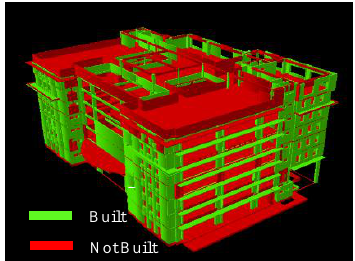
Figure 10. March 5, 2017 Predicted Status Isometric